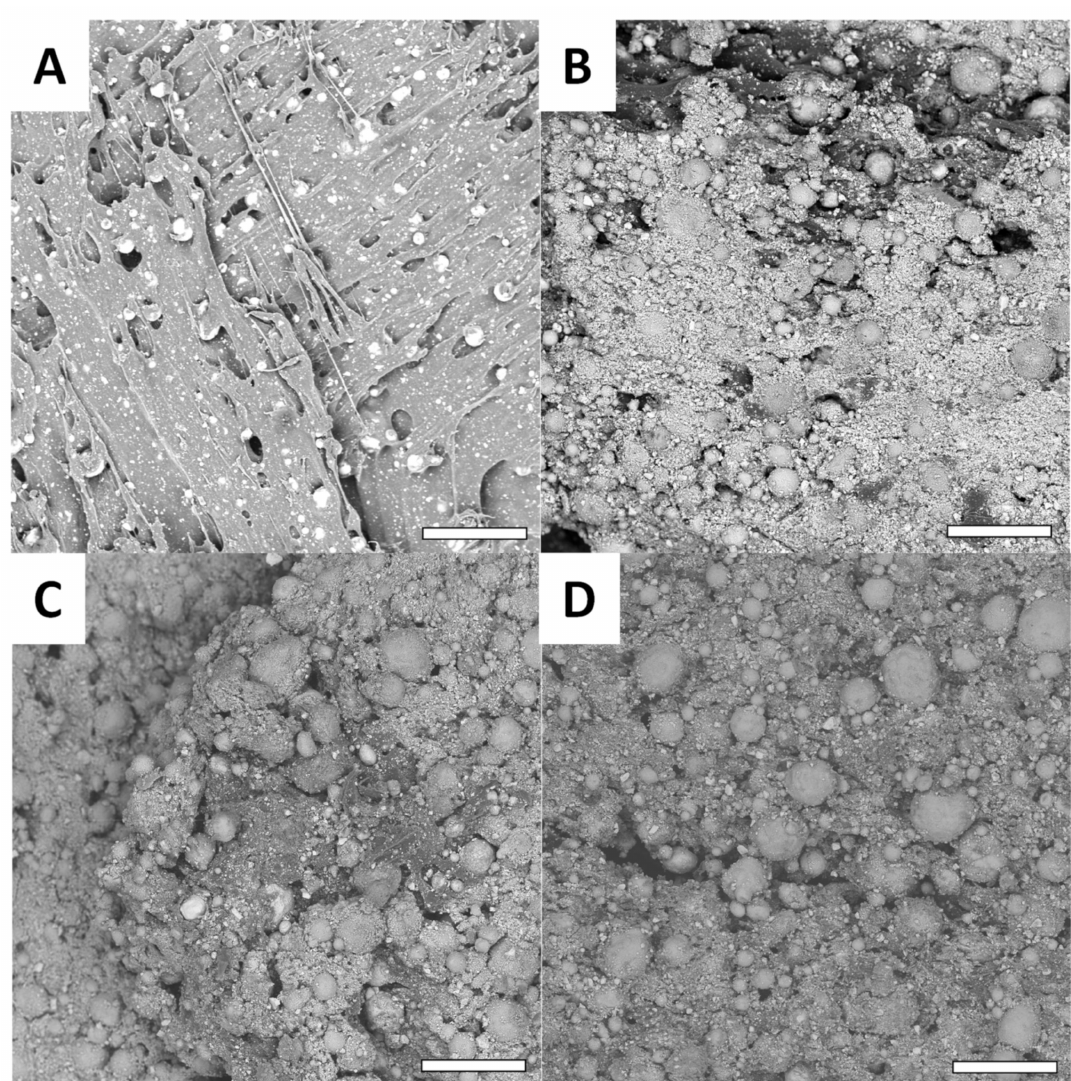
Figure 6. Examples of SEM images with low magnification (scale bar = 100 µ m). The presented surfaces are LMG surfaces, ( A ) Cu, ( B ) Cu(OH) 2 , ( C ) Methoxy and ( D )